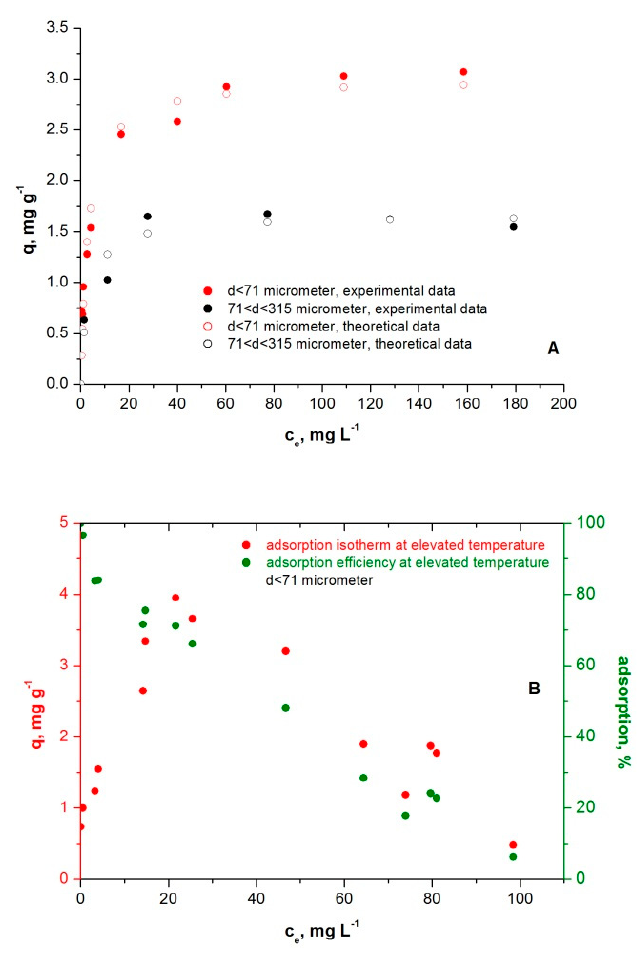
Figure 4. ( A ) The non-linearly fitted by using Langmuir equation and experimental adsorption isotherms of methylene blue on microcline containing particles smaller than 71 µ m ( d < 71 µ m) and in the range from 71 µ m up to 315 µ m (71 µ m < d < 315 µ m) in aqueous suspensions in the initial dye concentration range of 10–200 mg L − 1 at room temperature. ( B ) The adsorption isotherm of dye and the adsorption in percent determined in the initial dye concentration range of 10–105 mg L − 1 at the temperature of 60–65 ◦ C is presented against dye equilibrium